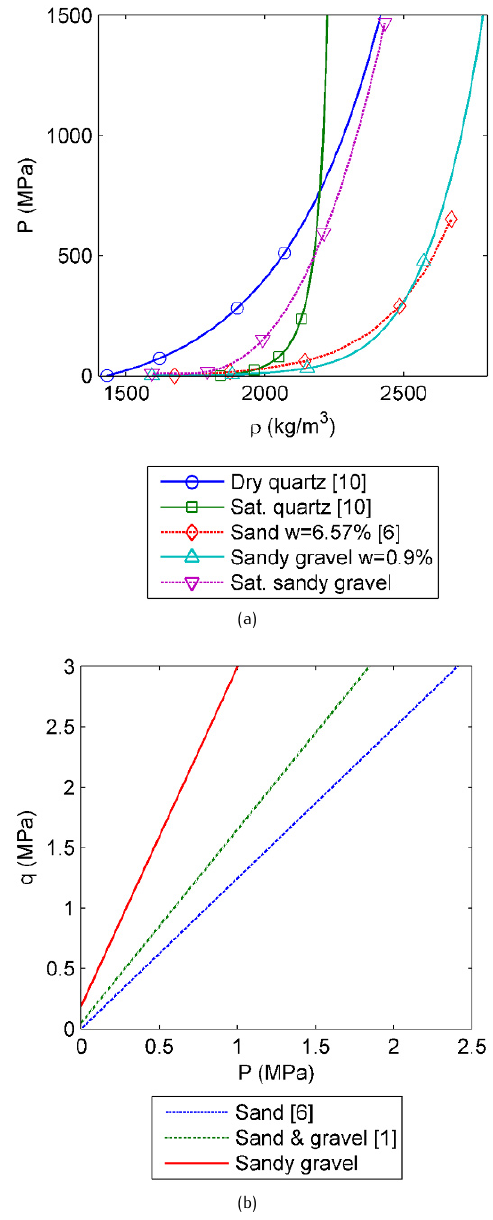
Figure 10. Literature data compared with present work. In a) volu- metric compression, b) deviatoric yield function. Unrefer- enced curves correspond to the present